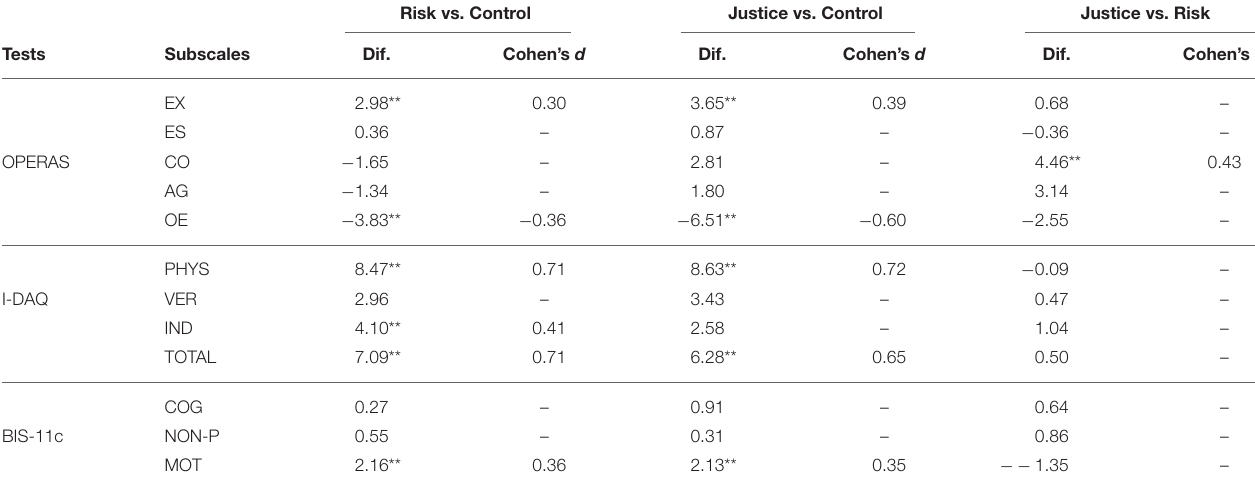
Risk vs. Control